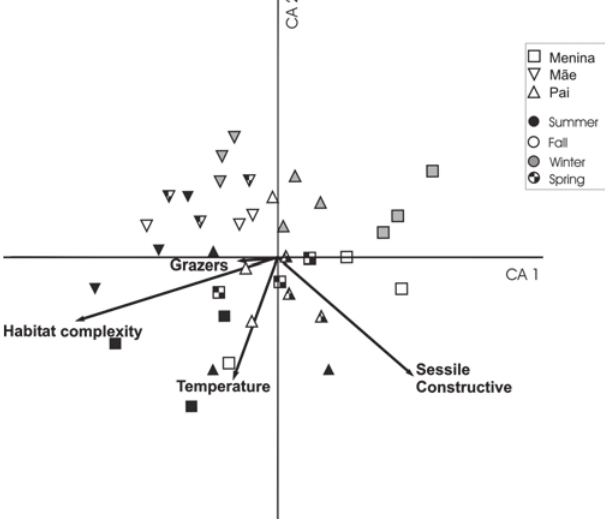
Fig. 4. Canonical Correspondence Analysis (CCA) of indi- vidual samples from Menina, Mãe and Pai Islands, indicating a Summer – Winter seasonal gradient and the correlated vari- ables that most probably explain sample distribution in the canonical space.